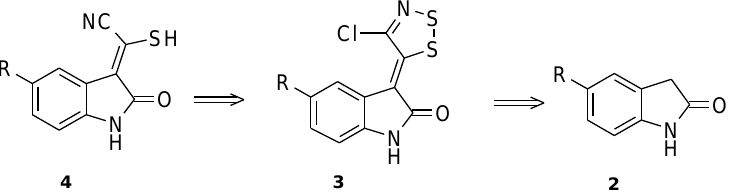
Figure 2. Retrosynthesis to 3-(4-chloro-5 H -1,2,3-dithiazol-5-ylidene)indolin-2-one derivatives ( 3 ) and original (2-oxoindolin-3-ylidene)-2-mercaptoacetonitriles ( 4 ). Performed at room temperature, the reactions between indolin-2-one derivatives (Scheme 2, 2a – d ) with a 1.1 equivalent of Appel’s salt (Scheme 2, 1 ) in dichloromethane led to the corresponding ( Z )-3-(1,2,3-dithiazol-5-ylidene)indololin-2-ones (Scheme 2, 3a – d ) in excellent yields (85–99%) (Scheme 2; Table 1).